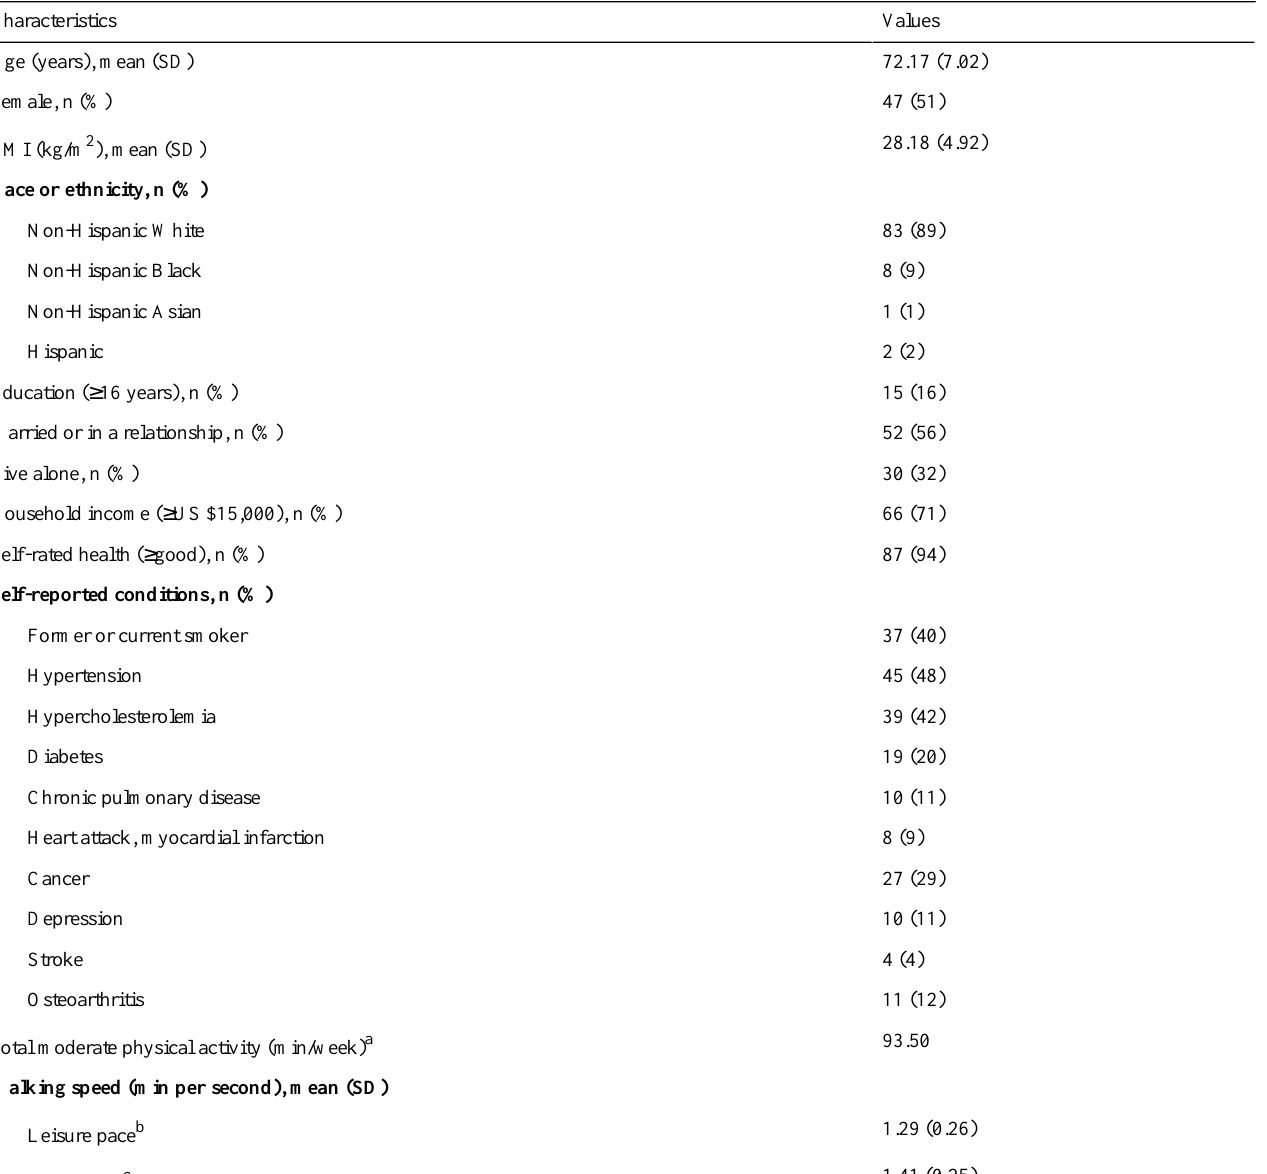
Table 2. Participant characteristics